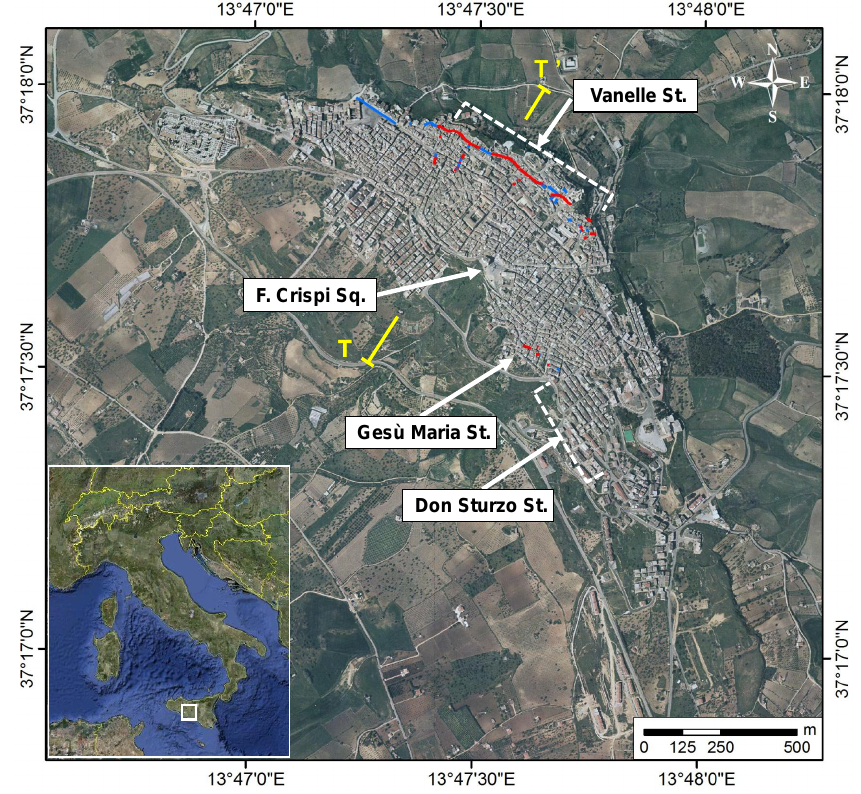
Fig. 3. Location map (inset, Google Earth 2010) and overview of the town of Naro (Italy). The most damaged buildings (event of 4 February 2005) are located in the areas of Vanelle St. (historic area) and Ges`u Maria St. (southeastern area). Fractures with millimetre (blue lines) and centimetre (red lines) aperture were mapped by the Regional Civil Protection Department (DRPC). T–T 0 cross section (yellow line) is shown in Fig.